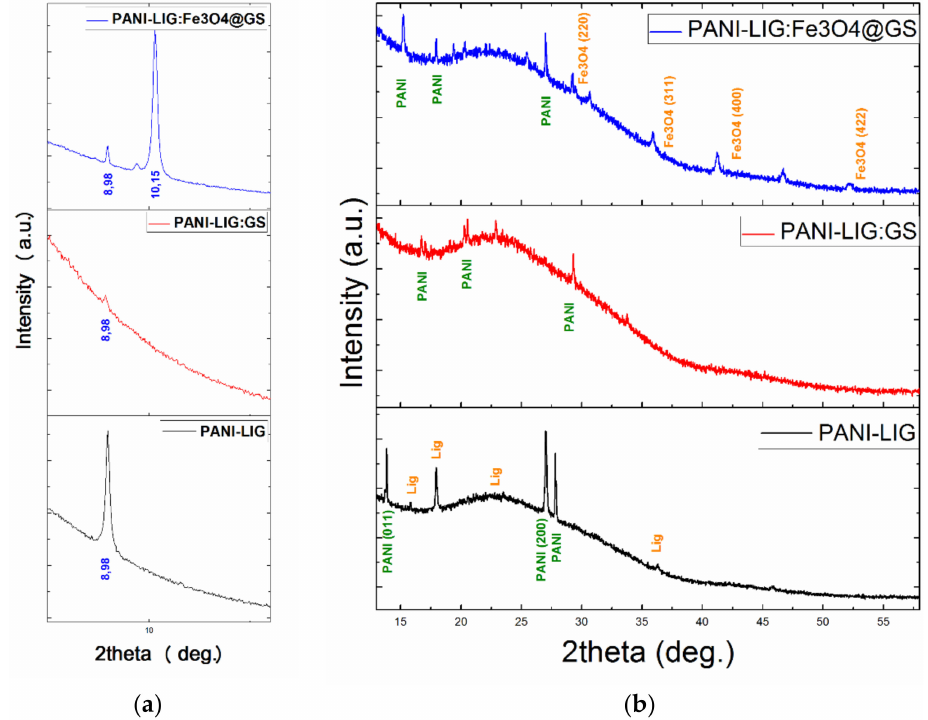
Figure 1. X-ray diffraction (XRD) patterns of polyaniline grafted lignin (PANI-LIG)-based coatings, corresponding to 7.5 to 13 ◦ ( a ) and 13 to 58 ◦ ( b ) diffraction angle regions,